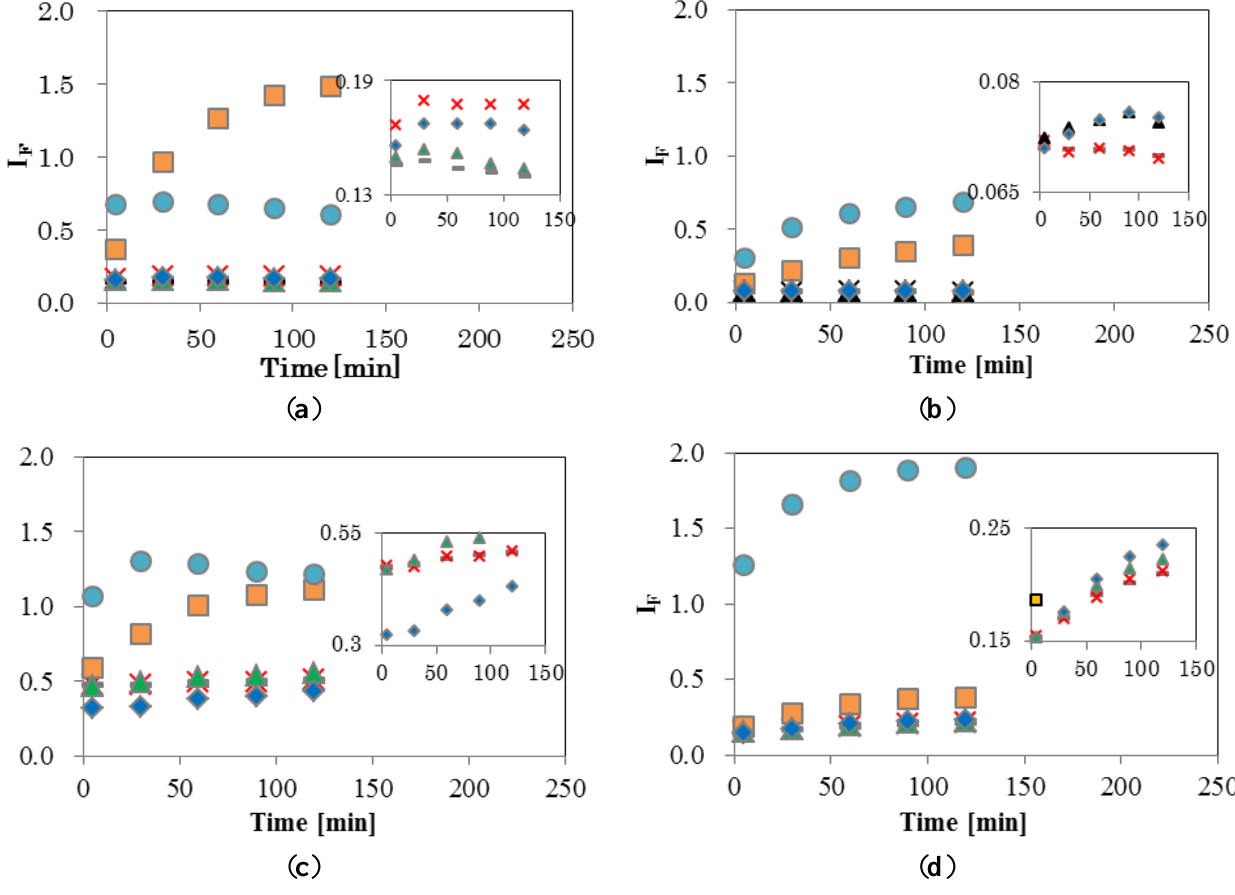
Figure 4. Temporal changes of I . ( a ) DPPC-CF-liposome; ( b ) DPPCch-CF-liposome; F ( c ) PCPE-CF-liposome; and ( d ) PCPEch-CF-liposome. – (gray); negative control, × (red); E2, □ (orange); NPh, ▲ (green); BPA, ◊ (blue); BBP and ● (light blue); TBT. Sample size; n = 3, standard deviations are 10% or